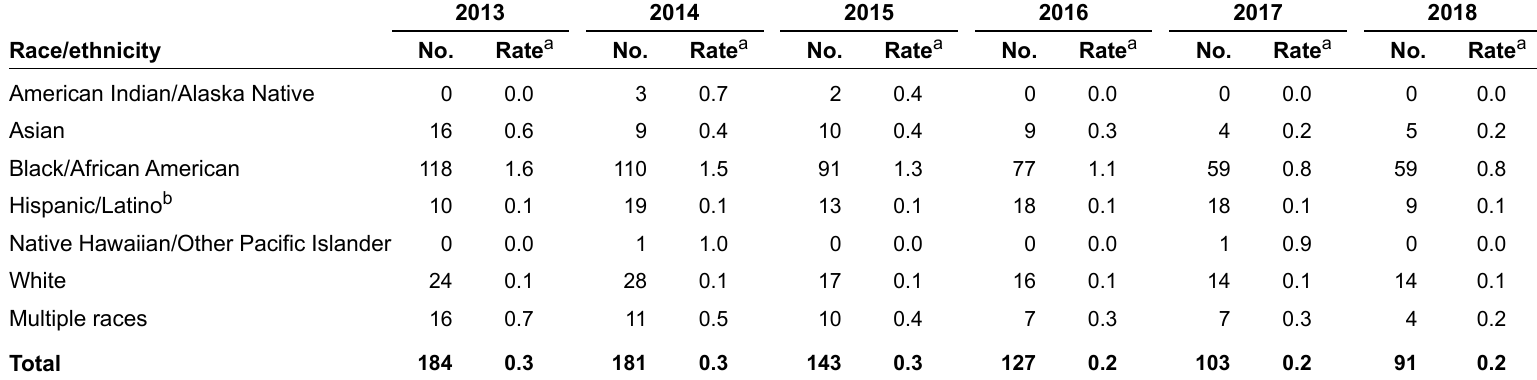
Table 13a. Diagnoses of HIV infection among children aged <13 years, by race/ethnicity, 2013–2018—United States